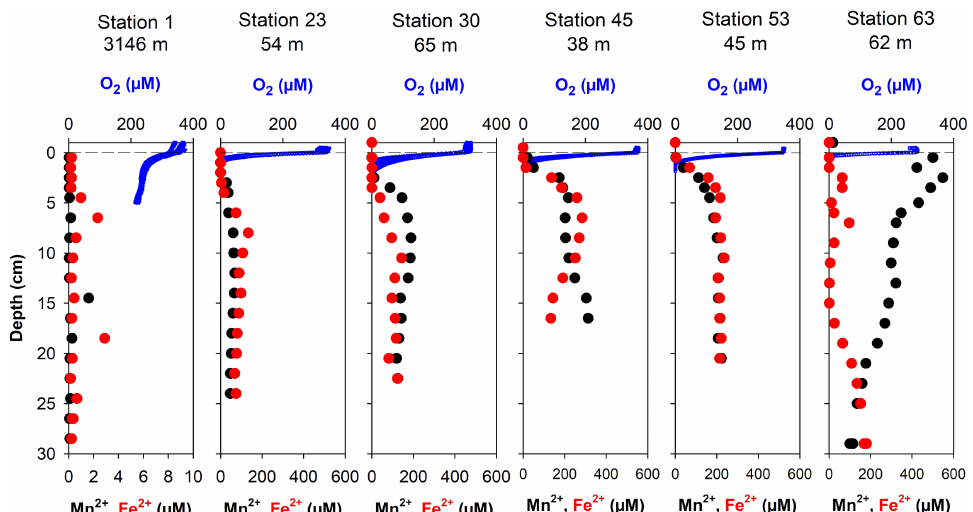
Figure 2. Depth profiles of dissolved O 2 measured with microelectrode sensors for Stations 1, 23, 30, 45, 58, and 63 and profiles of pore- water concentrations of dissolved iron and